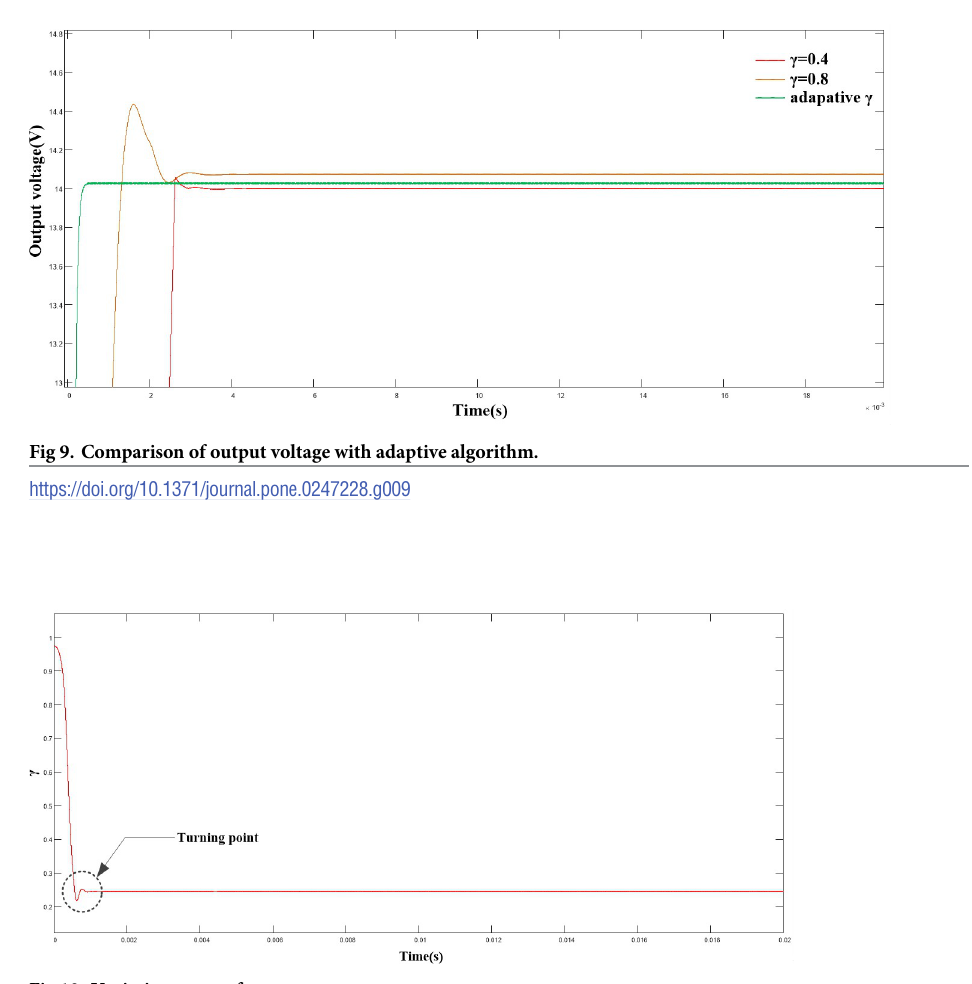
Fig 10. Variation curve of γ parameter.